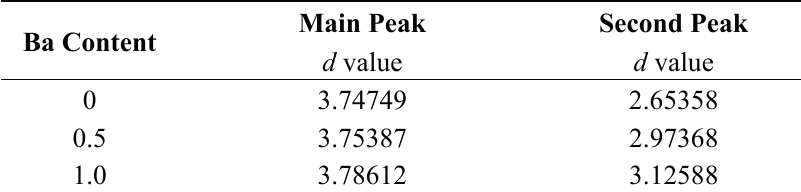
Table 4. d value of main peak and second